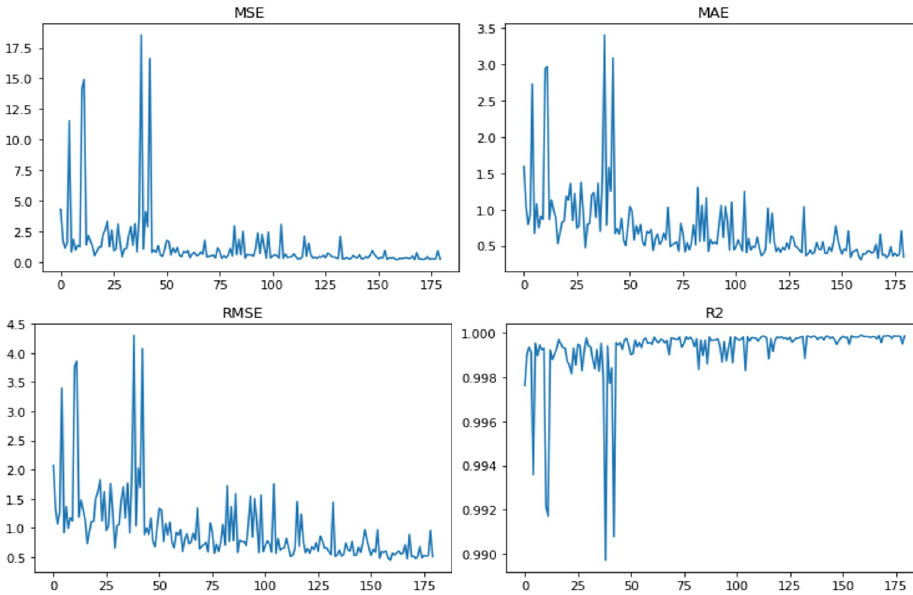
Figure 8. Training performance of the 180 different neural networks.